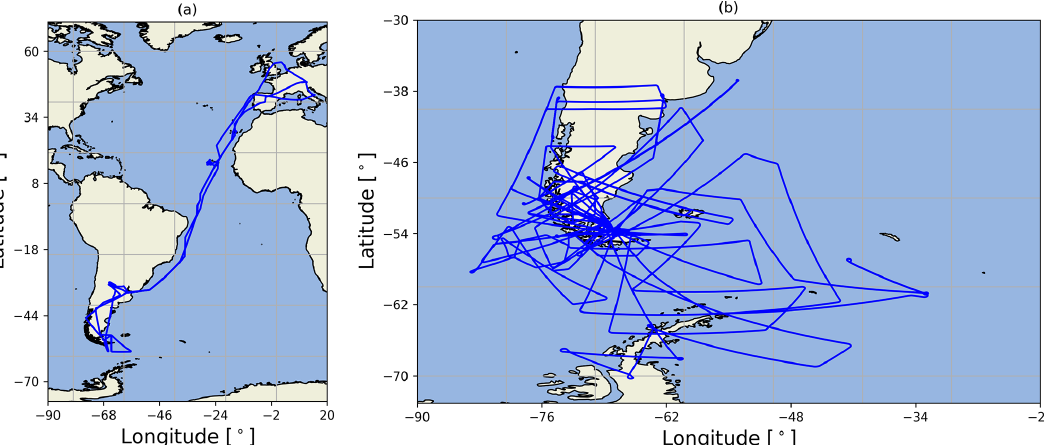
Figure 1. Flight tracks of HALO of (a) the transfers from and to Oberpfaffenhofen, Germany (48 ◦ N, 11 ◦ E) and (b) during the two phases with the base in Rio Grande, Argentina (53 ◦ S, 67 ◦ W).